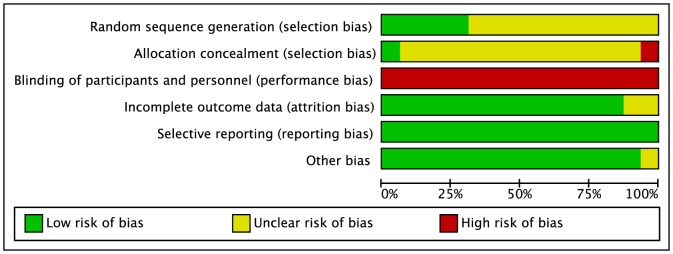
Risk of bias assessment tool.Across trials (n = 15), information is either from trials at a low risk of bias (green), or from trials at unclear risk of bias (yellow), or from trials at high risk of bias (red).